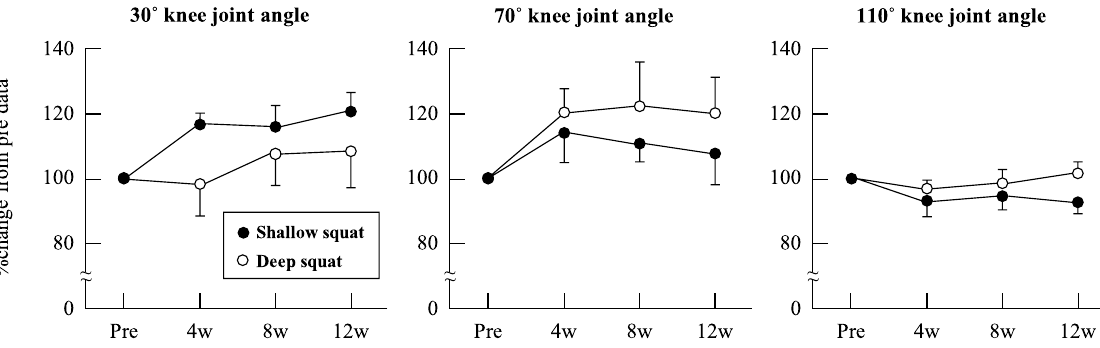
Figure 2. Relative changes in knee extension peak torque at a knee joint angle of 30°, 70°, and 110° as a result of squat training in the shallow squat and deep squat groups. Error bars show standard error were conducted using the right leg. The hip was fixed to the dynamometer using a strap, with the hip joint at 90° flexion, and the ankle was attached to a pad linked to the force transducer. The knee extension tasks at the three selected knee joint angles were performed in a random order. The MVC trial included a gradual increase in knee extension force to maximum effort in 1–2 s, and a plateau phase at maximum effort was maintained for 4 s. Participants performed at least two trials with a ≥ 2-min rest interval between them. The highest MVC force was selected from the trials. KEPT torque was calculated as the product of the MVC force and distance of the lever arm. For the 5 m preferred/fast walk test, four parallel lines were taped on the floor at a distance of 1 m, 6 m, and 7 m (finish line) from the start line (0 m). Participants then walked from the starting to the finish line at their usual and maximum speed. The researcher timed how long it took participants to walk from the 1 m to 6 m lines while walking alongside them 10 .